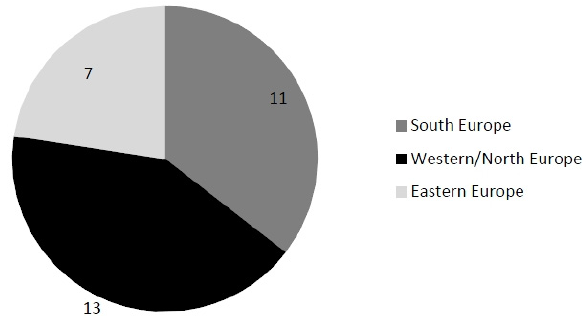
Figure 2. Geographical distribution of European